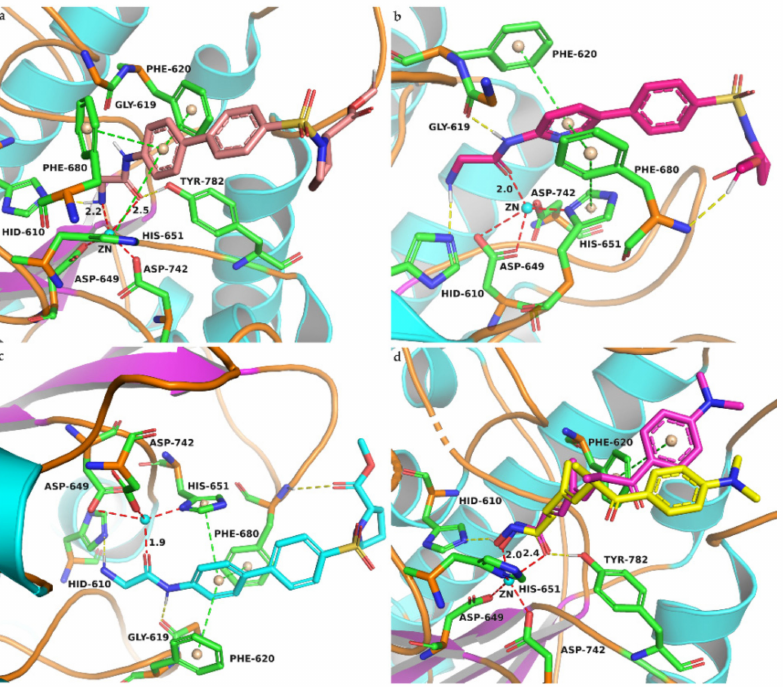
Figure 8. Three-dimensional interaction pattern diagram of 7a ( a ), 7d ( b ), 13a ( c ), and TSN ( d ) with HDAC6. Hydrogen bonds are represented by yellow dashed lines; π – π stacking interactions are represented by green dashed lines; the zinc ion is shown as a cyan ball; coordination interactions are represented by red dashed lines and distances are given in Å. Co-crystallised ligand TSN colored in